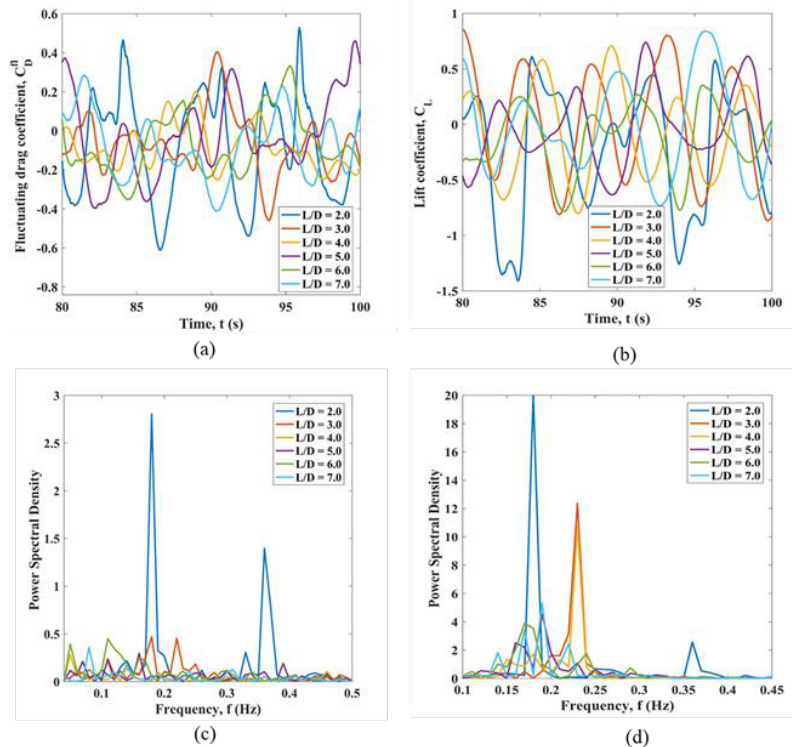
Figure A10. Fluid force coefficients for cylinder 6 immersed in planar sheared flow: ( a ) time history of the fluctuating drag coefficient; ( b ) time history of the lift coefficient; ( c ) the fluctuating drag co–efficient FFT; ( d ) the lift coefficient FFT.